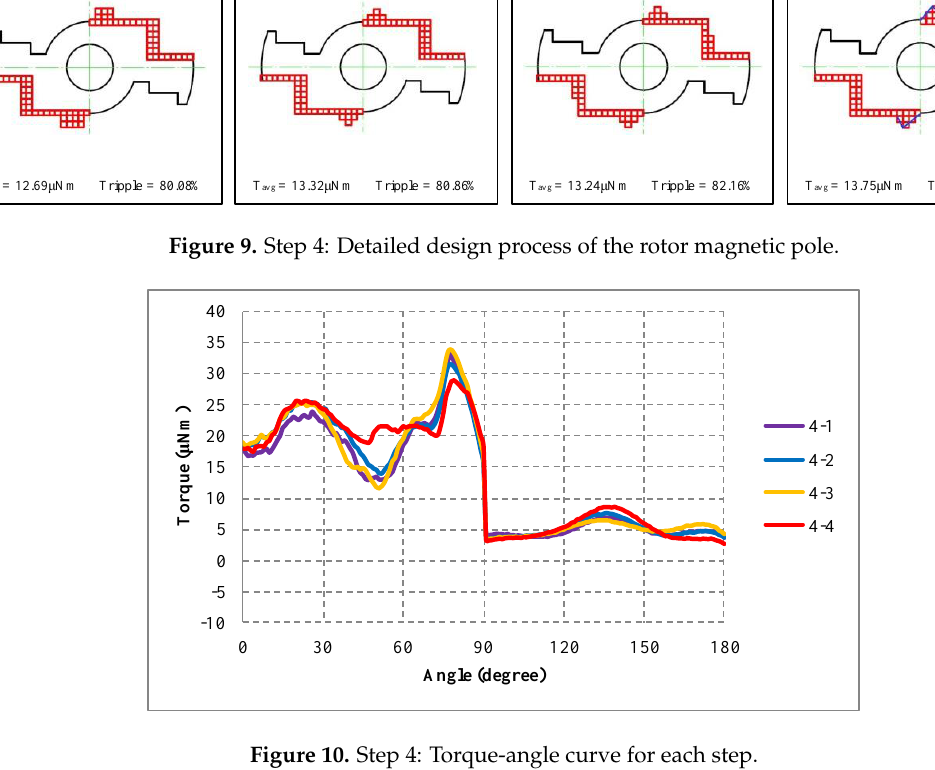
Figure 10. Step 4: Torque-angle curve for each step.